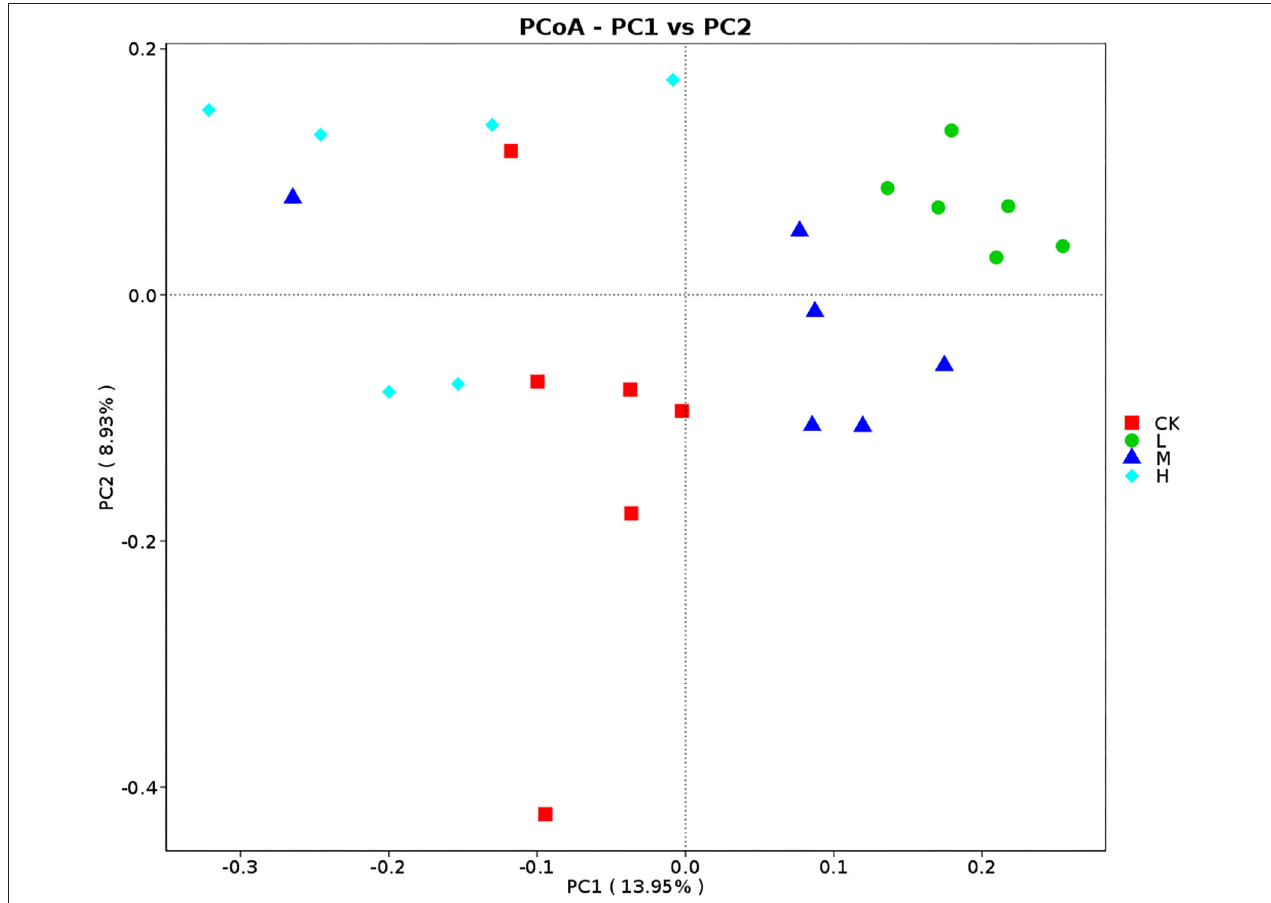
FIGURE 4 | PCoA (Bray–Curtis) of rumen bacteria in Tibetan sheep at the four SeY doses (mg SeY/kg dry matter) (CK, 0; L, 0.09; M, 0.18; H, 0.36). CK, control; L, low Se, M, medium Se; H, high